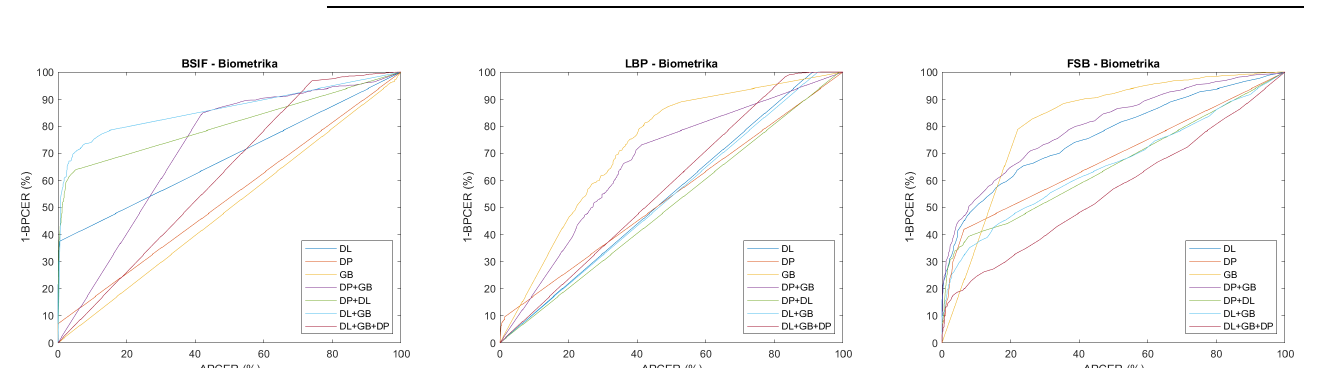
Figure 4. Comparison between ROCs of our self-trained PAD systems in an intra- (dashed) and cross- (solid) sensor scenario on the Biometrika dataset from LivDet